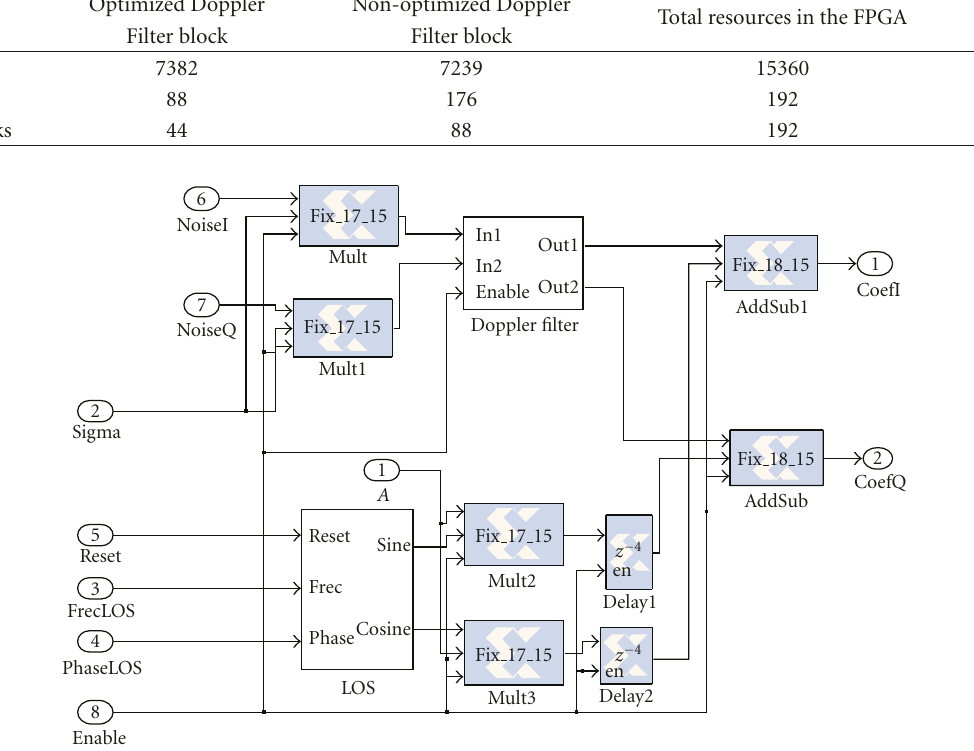
Figure 5: Generation and addition of the LOS and NLOS components of each